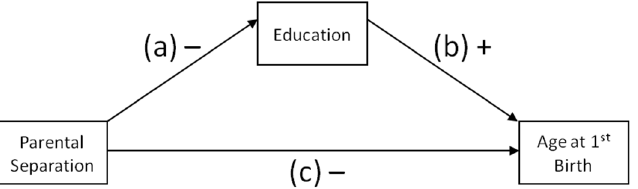
Figure 4. Schematic of mediation analyses run for each measure of parental absence. The direction of effects is accurate for most models. Deviations from these directions are specified in Figure 5. Table 3. Standardized effects of mediation analysis by gender, generation, and type of parental ab- sence. Bootstrapped standard errors are shown.